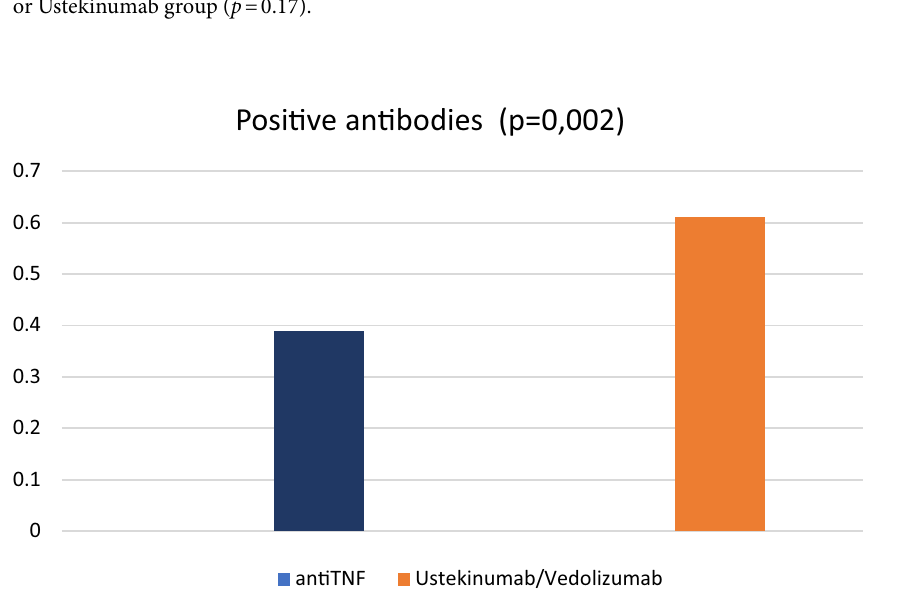
Figure 1. Percentage of antibody-positive patients on anti-TNF or Vedolizumab/Ustekinumab